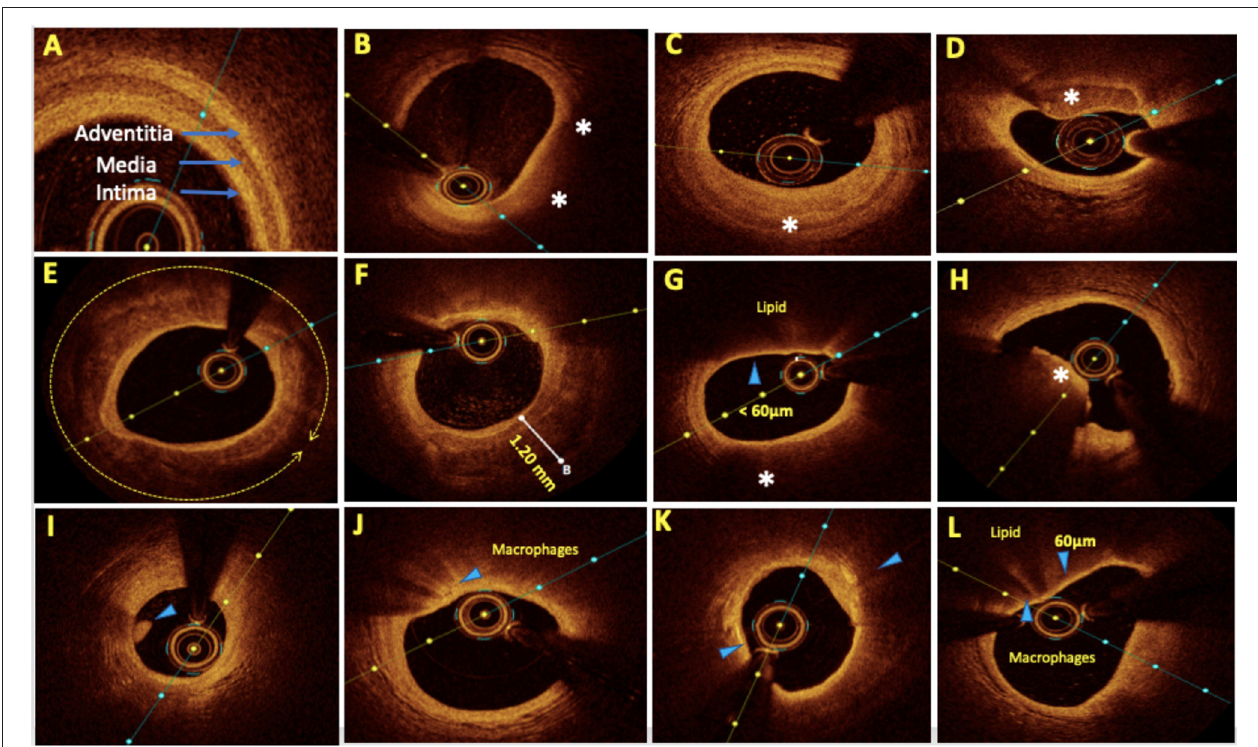
FIGURE 1 | Representative optical coherence tomography (OCT) images with various plaque morphologies. (A) Normal coronary, (B) lipid-rich plaque (LRP), (C) fibrotic plaque, (D) calcific nodule, (E) near 360 ◦ arc of calcific plaque, (F) deep calcium deposition, (G) thin cap fibroatheroma (TCFA), (H) intraluminal red thrombus, (I) intraluminal white thrombus, (J) bright spots or bands at the boundary between the fibrous cap and lipid core suggestive of macrophages, (K) bright signal-rich cholesterol crystals, and (L) vulnerable plaque formed by a large lipid pool covered by TCFA with macrophage infiltration. Areas of interest were highlighted by arrows and